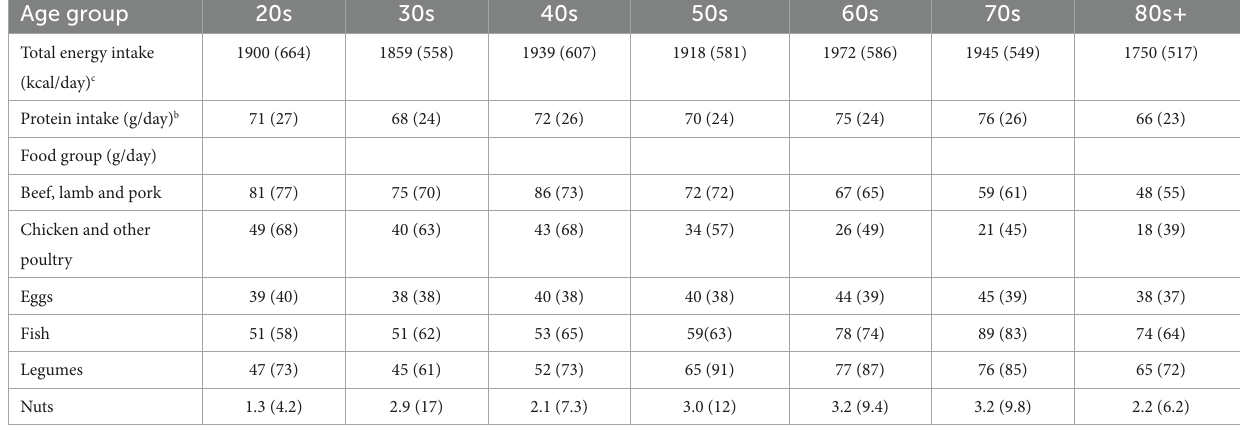
TABLE 2 Total energy intake, protein intake, and National Health and Nutrition Survey dietary intake of protein foods a by age. Age